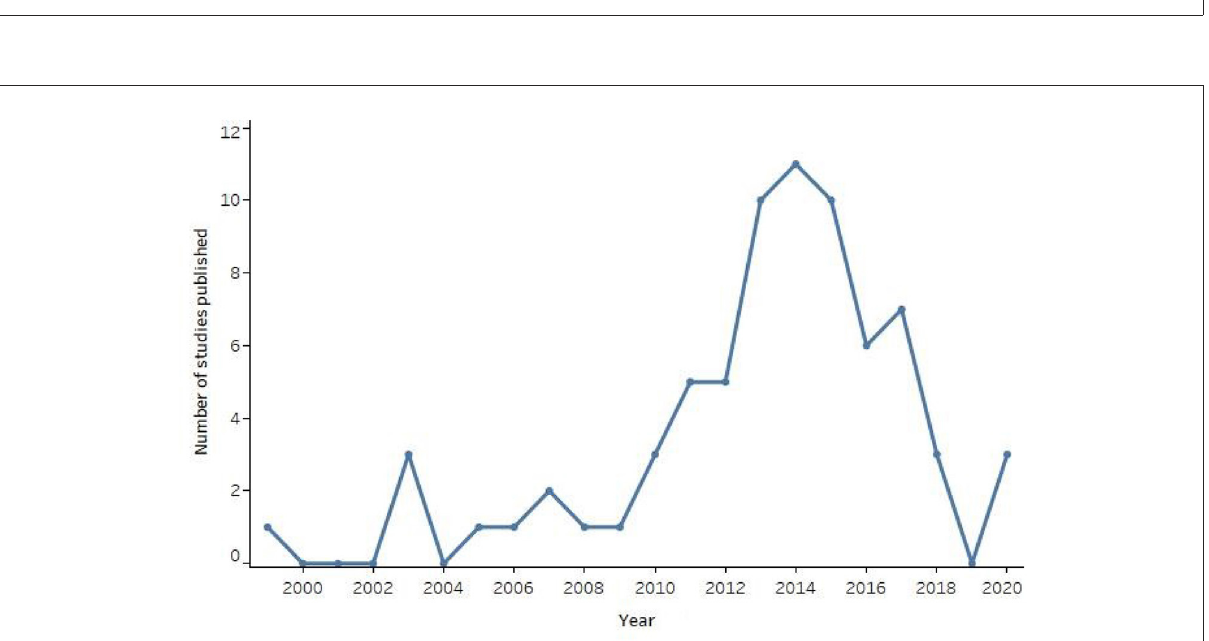
FIGURE2 Number of included AAC-BCI studies published per year, 1999–2020.